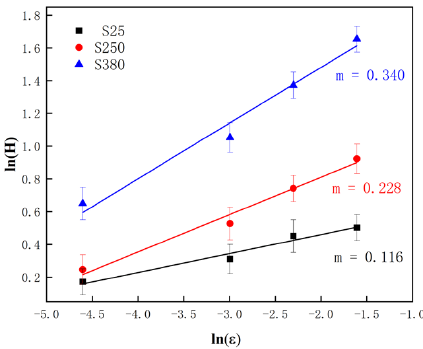
Figure 9. Determination of the strain rate of hardness(m) for S25, S250, and S380. Table 1. The detailed measurement data on STZ for various